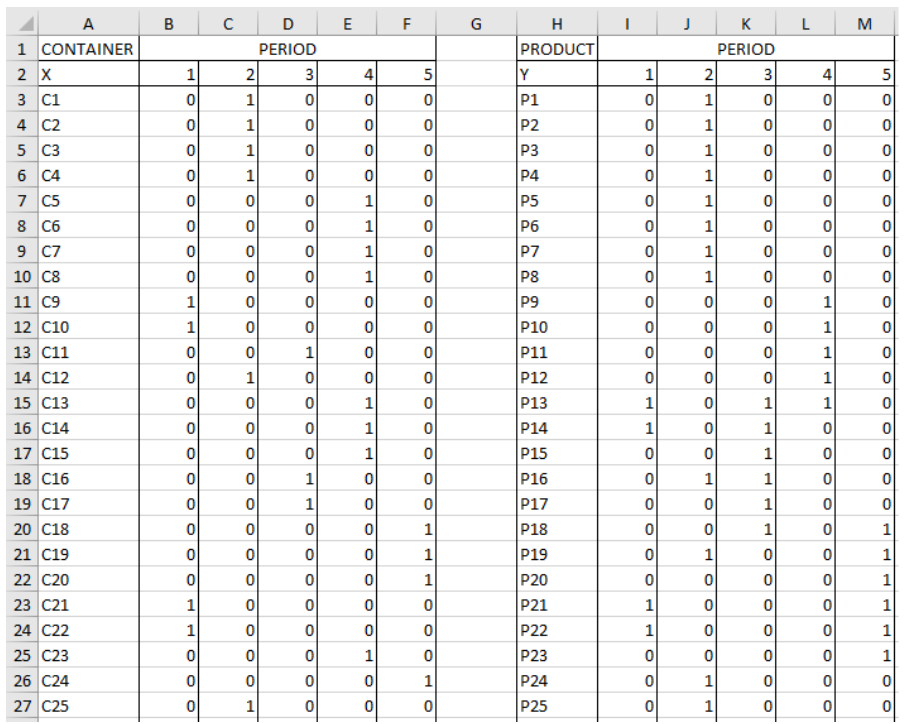
Figure 8. Results of Case 4 in the form of Excel spreadsheet. Table 5. Summary of the result for Case 4.